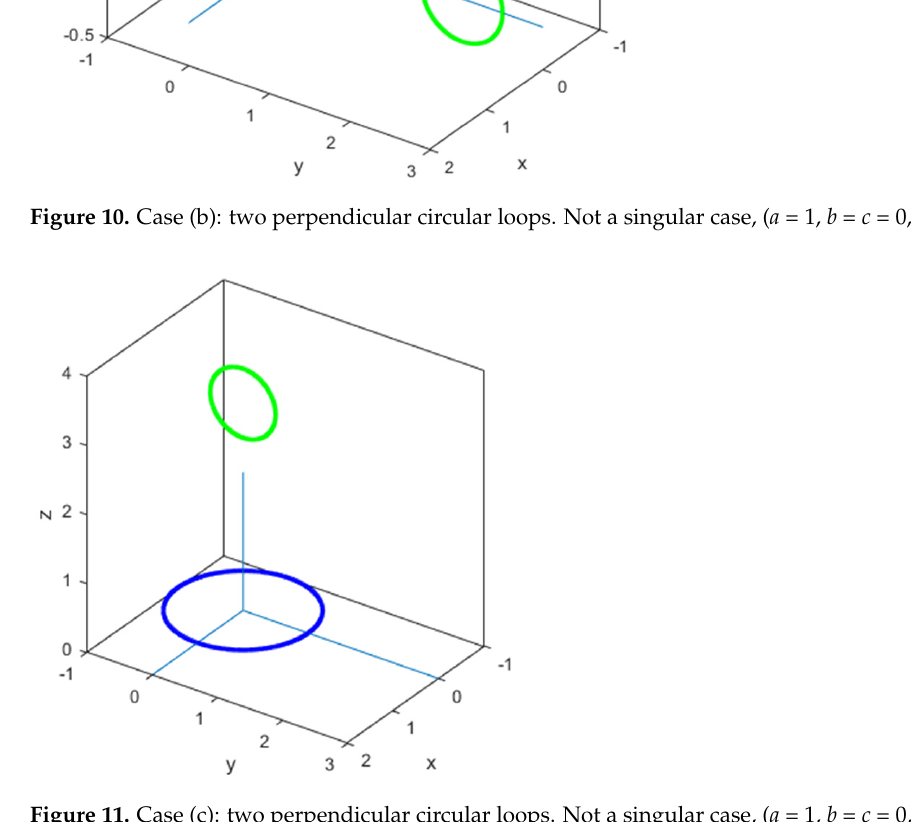
Figure 9. Case (a): two perpendicular circular loops. Not a singular case, ( a = 1, b = c = 0, L = l = 1).